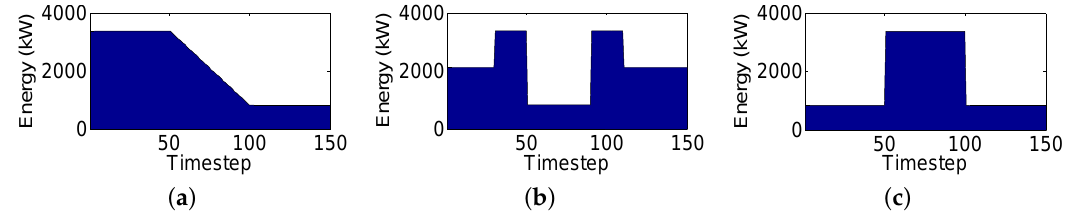
Figure 4. Power reference profiles. ( a ) profile A; ( b ) profile B; and ( c ) profile C.